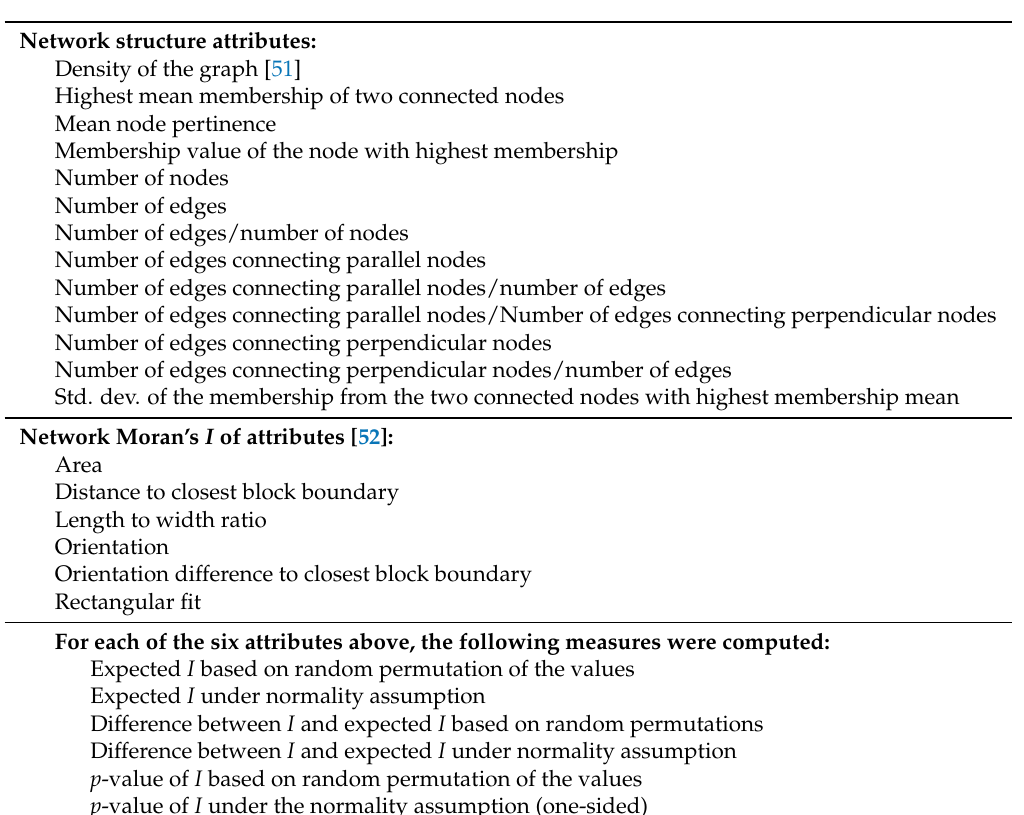
Table 4. Attributes computed from the network of polygons extracted inside each